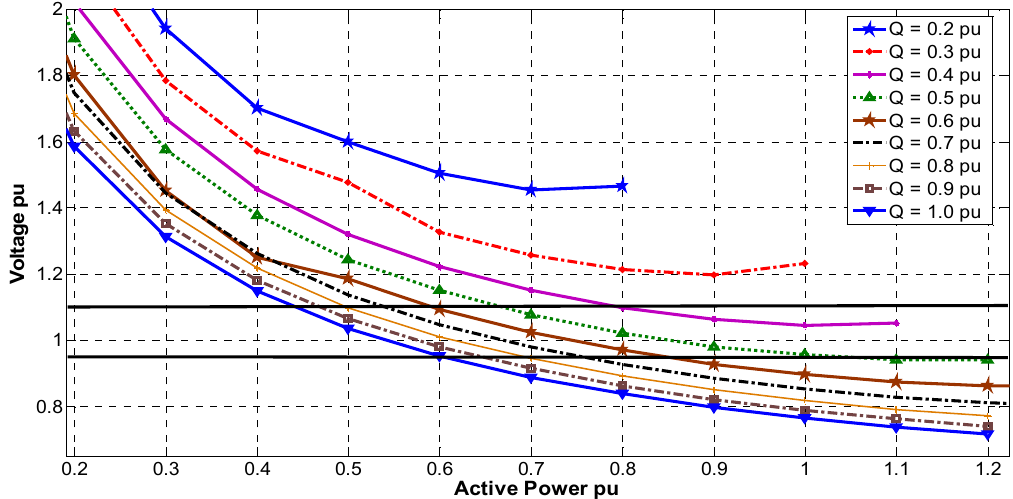
Figure 6. Variation of terminal voltage with active and reactive load.